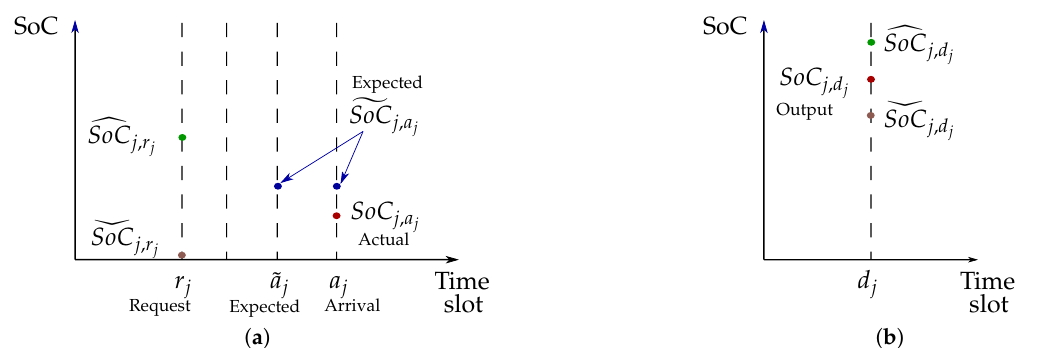
Figure 2. Expected and actual time and state of charge for the j th electric vehicle. ( a ) Arrival. ( b )